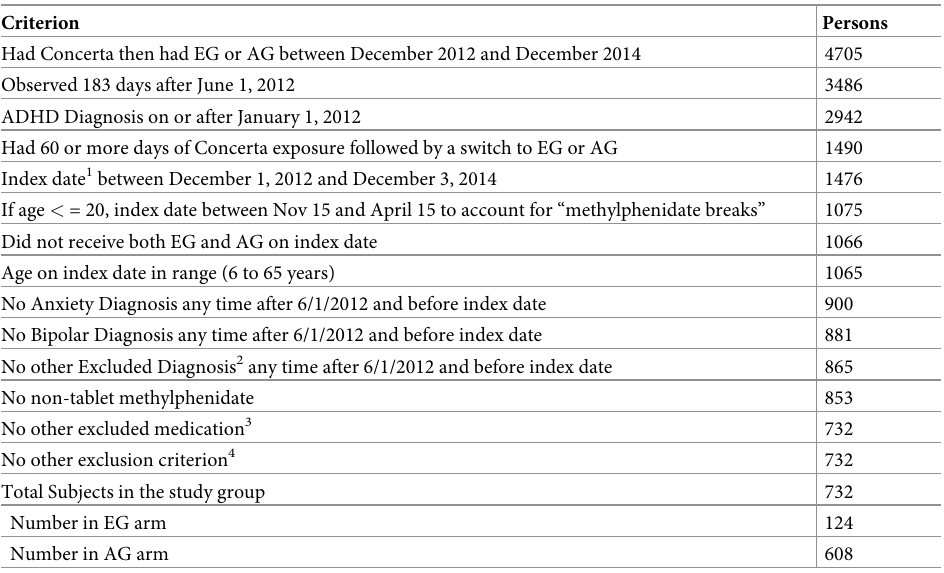
Table 1. Selection of the study